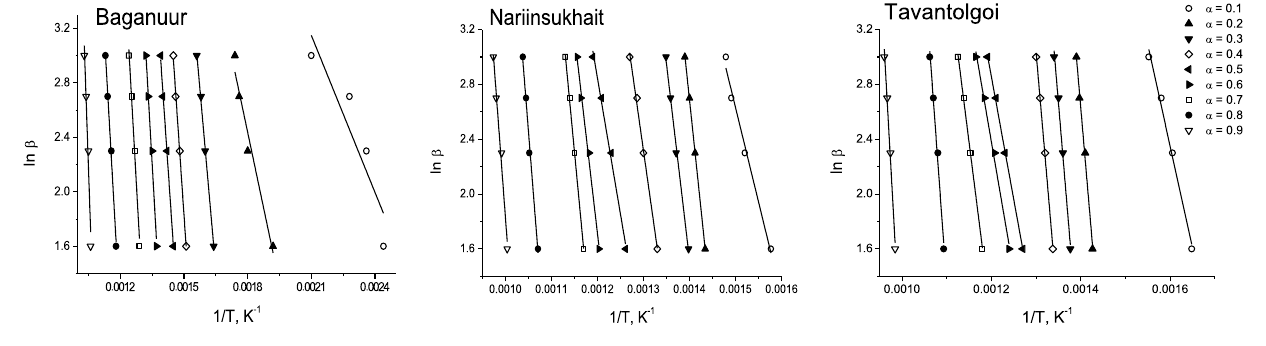
Fig. 7 Arrhenius plots of coals with OFW